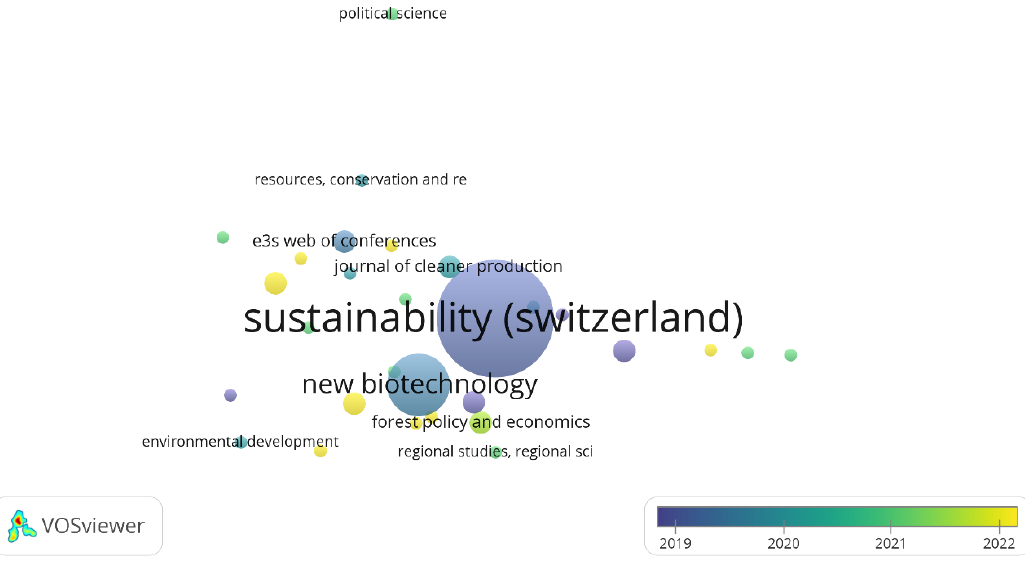
Figure 3. Bibliometric coupling analysis/sources. Source: VOSviewer output.